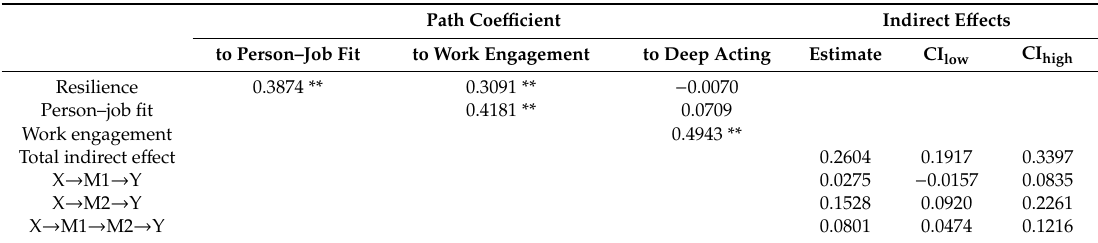
Table 4. Double mediation e ff ect